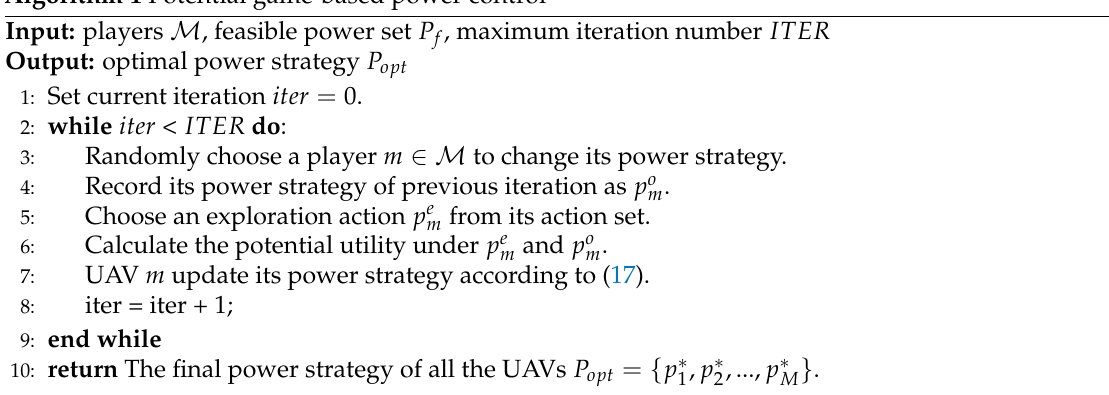
Algorithm 1 Potential game-based power